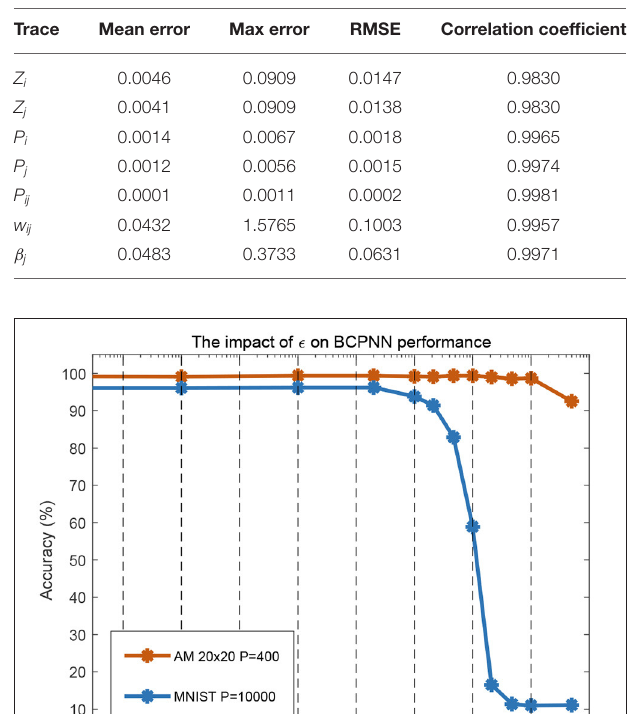
TABLE 3 | Analog circuit implementation results of 5-s simulation with dense spikes.